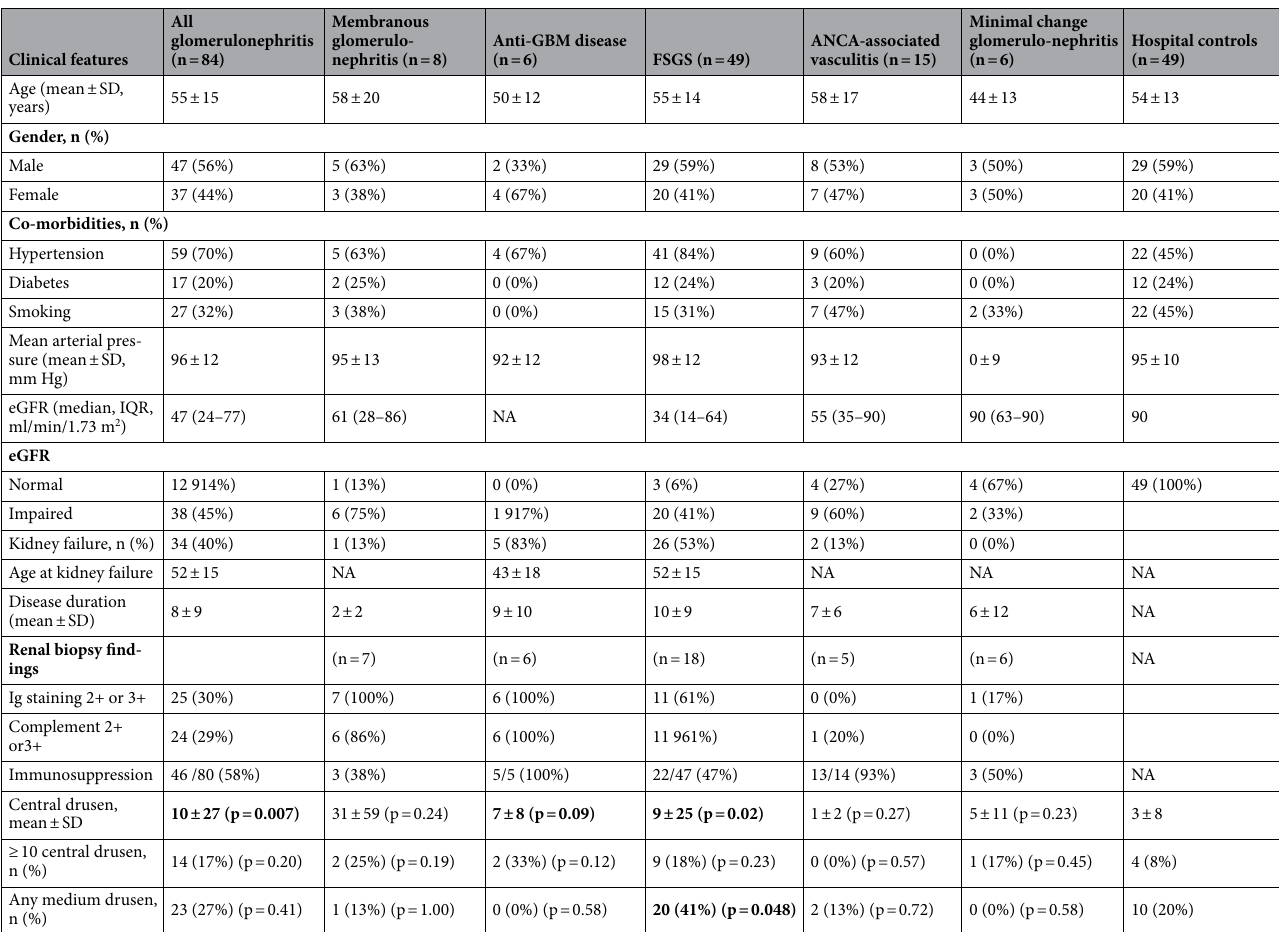
Table 2. Clinical features and drusen counts in different forms of glomerulonephritis. Significant values are in bold. CI confidence interval, eGFR estimated glomerular filtration rate mL/min/1.73 m 2 , IQR interquartile range, SD standard deviation, NA not